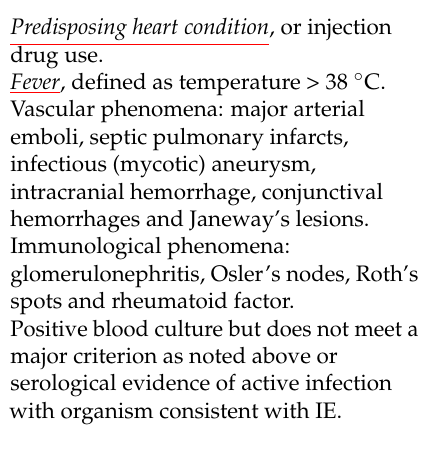
Table 1. Modified Duke criteria (adapted from Habib G. et al. [10]). Major